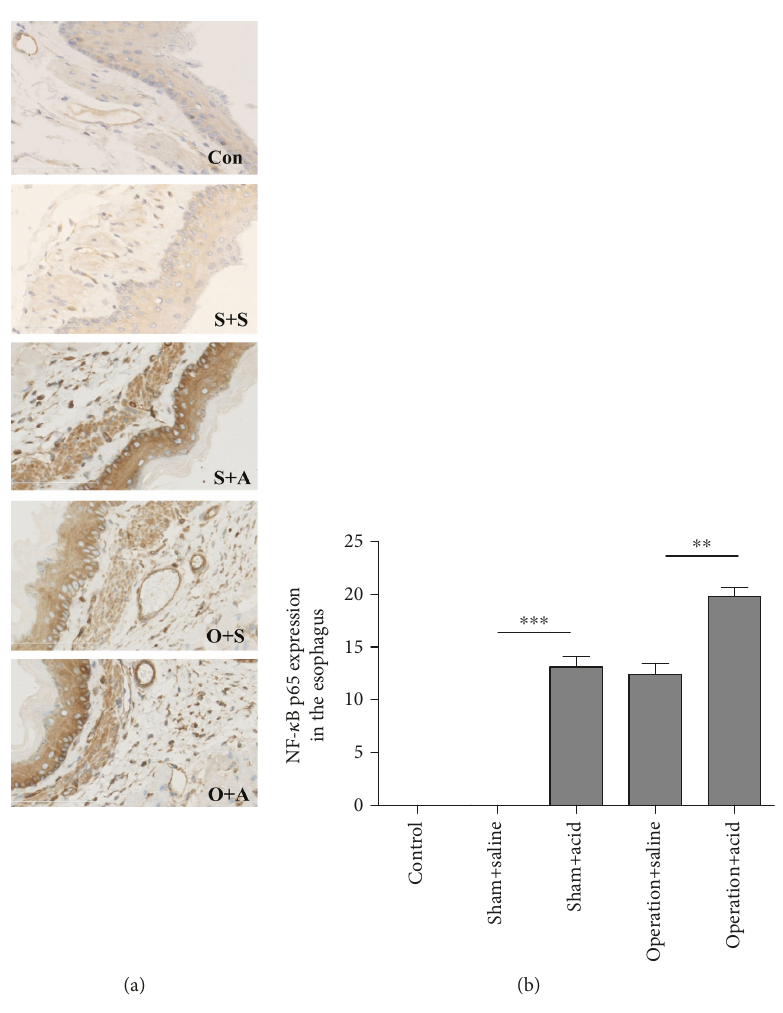
Figure 4: Esophageal instillation and DMV destruction caused activation of NF- κ B in esophageal tissue of rats. (a) NF- κ B p65-positive cells with dark brown nuclei in the esophagus of all animals. Con: control group ( × 400); S+S: sham + saline group ( × 400); S+A: sham + acid group ( × 400); O+S: operation + saline group ( × 400); O+A: operation + acid group ( × 400). (b) The activation of NF- κ B p65 in the lower esophageal segment increased more signi fi cantly in the operation + acid group than in the operation + saline group ( P < 0 01 ). No signi fi cant di ff erence in the NF- κ B p65 activation in the esophagus was observed between the operation + saline group and the sham + acid group ( P > 0 05 ). In the control and sham + saline rats, NF- κ B p65 activation was not observed ( n = 8 , ∗∗ P < 0 01